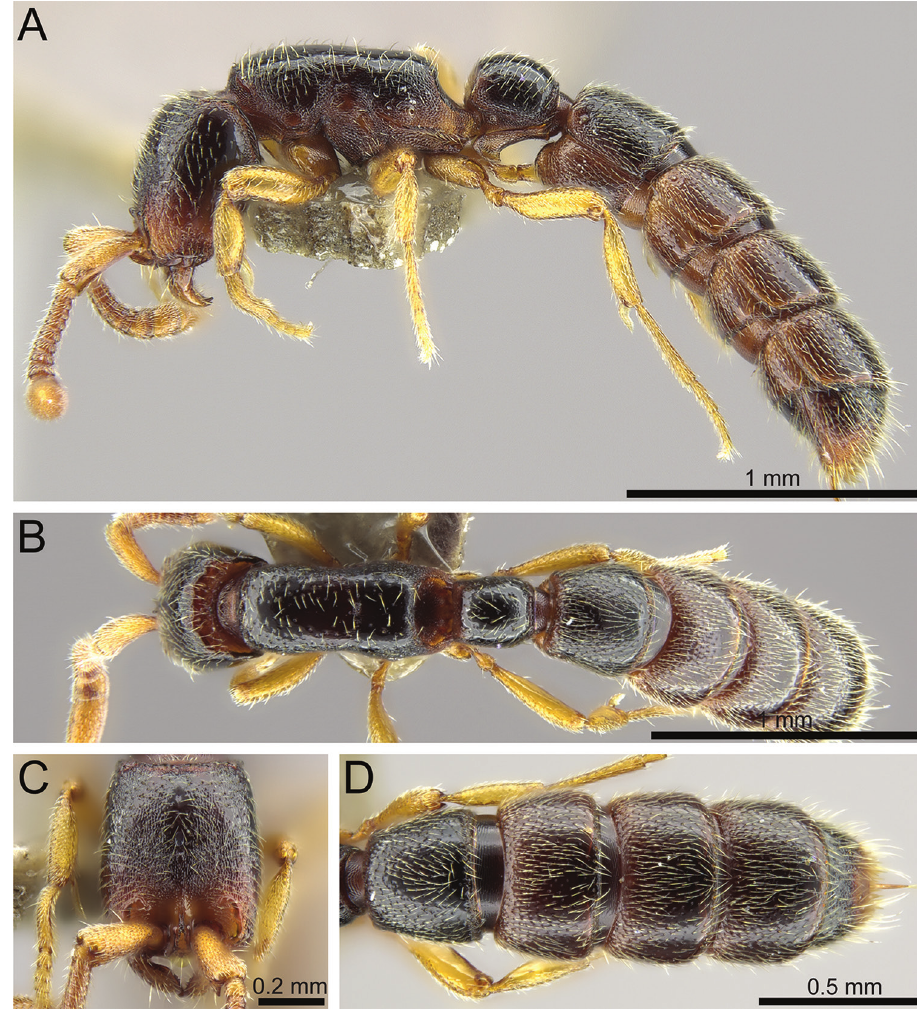
Figure 11. Zasphinctus wilsoni sp. n. holotype worker (MCZ-ENT-00512764). A Body in profile B Body in dorsal view C Head in full-face view D Abdominal segments III–VII in dorsal view. cessible 3D surface model of the holotype at Sketchfab (https://sketchfab.com/models /36bab7ecaa8d45b18013ea679b7ca54a). Differential worker diagnosis. See Table